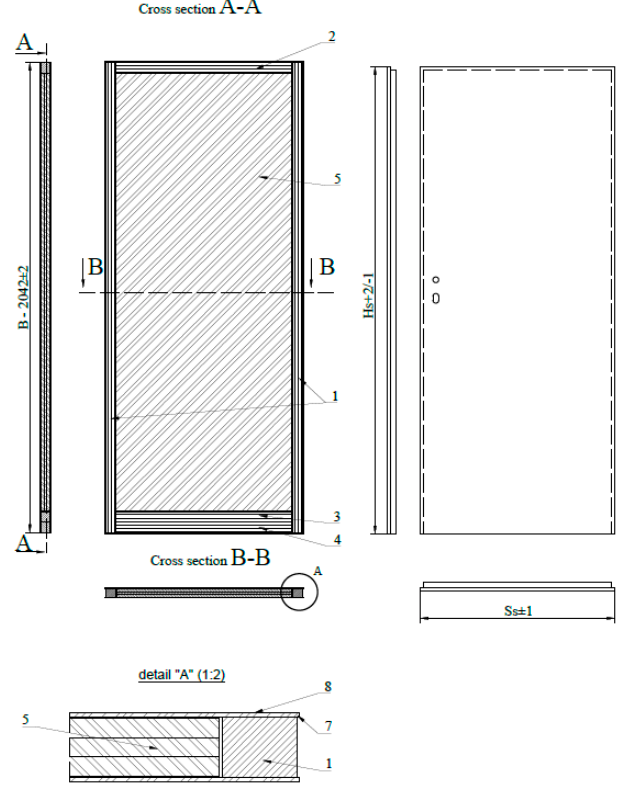
Figure 6. Door construction 4.